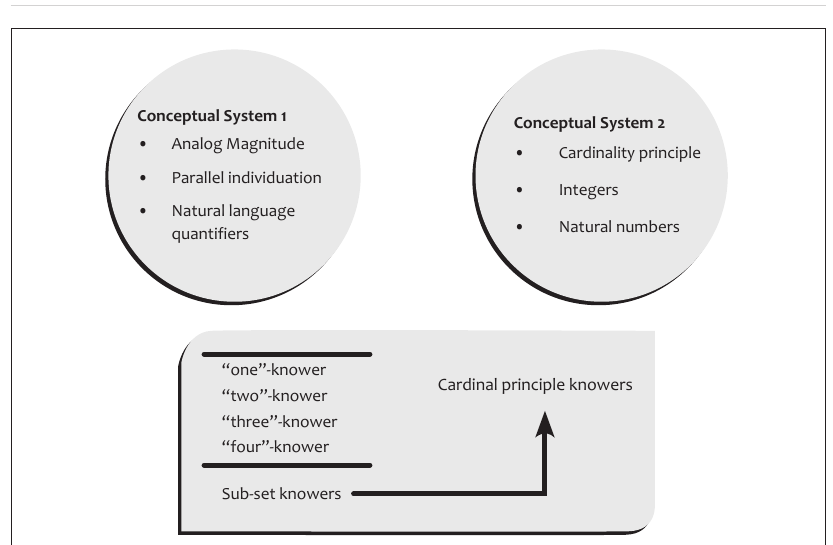
Figure 2: From “one”- knower to Cardinal principle knower